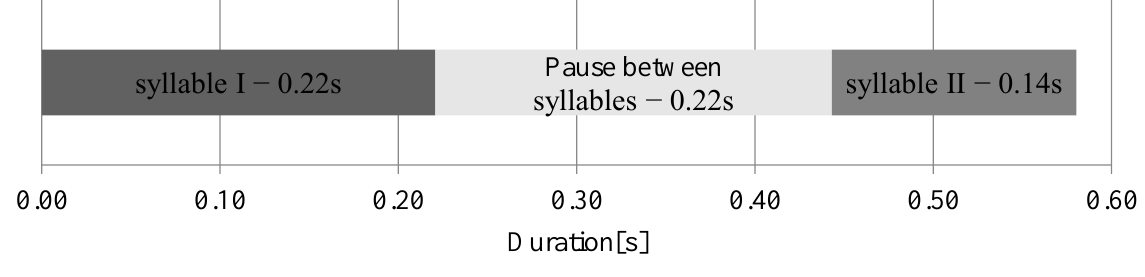
Figure 2. The mean duration of vocalization.